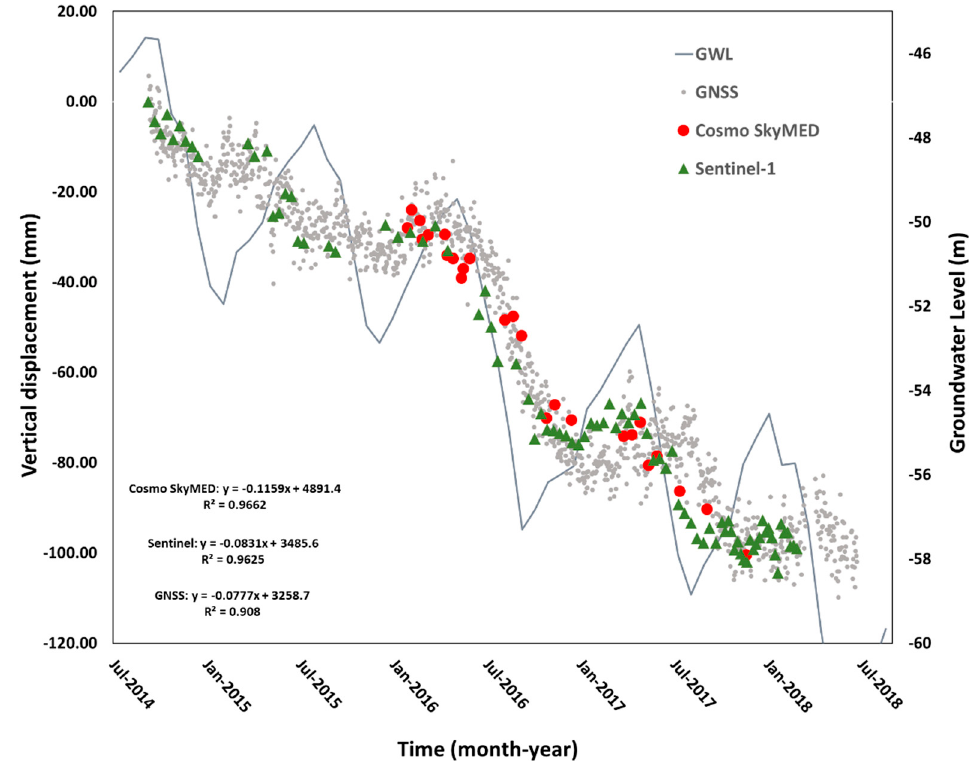
Figure 7. Vertical displacement time series at the KAPN GNSS station derived from GNSS, COSMO- SkyMed and Sentinel-1 observations. The figure also displays groundwater level measured at a well (well no: 52258), which is located 3 km southwest of the KAPN station.